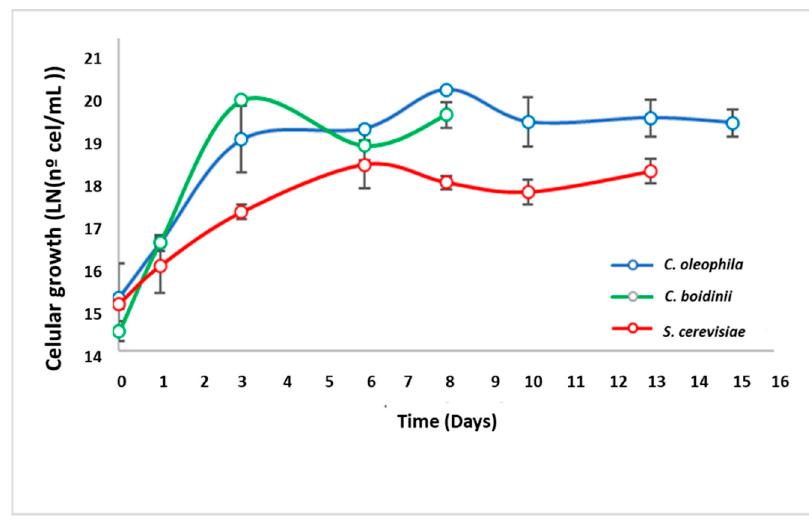
Figure 4 . Evolution of cell proliferation in sequential fermentations (Sauvignon Blanc). Table 4. Sequential fermentations of Sauvignon Blanc from Casablanca Valley (Valpara í so, Chile).